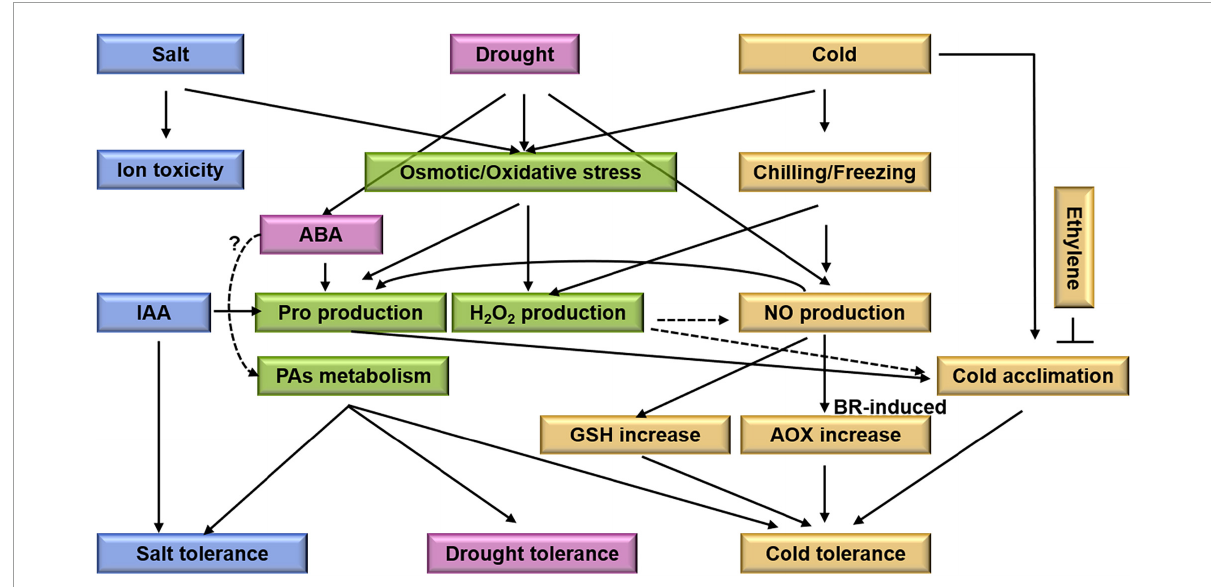
FIGURE5 A schematic representation of cross-talks between drought, salt, and cold stress in M. truncatula . Drought, salt, and cold stress cause secondary stress including osmotic stress and oxidative stress. And then induce proline and H 2 O 2 production. In M. truncatula , ABA could induce proline accumulation, contributing to osmotic adjustment under drought condition. And NO in cold acclimation through regulation on GSH synthesis and redox is associated with the differential cold tolerance. Meanwhile, ethylene reduces cold acclimation-induced freezing tolerance. IAA may have positive effects on their development and differentiation under salt stress. PAs as compound positively regulate M. truncatula in response to drought, salt, and cold stress. Ion toxicity and cold acclimation are specific process for salt stress and cold stress, respectively. Blue boxes indicate salt related elements. Pink and yellow boxes indicate drought and cold related elements, respectively. Green boxes indicate the central elements between drought, salt, and cold stress. The black arrows represent the targets, the dotted lines represent the possible regulatory targets and the cross-lines mean